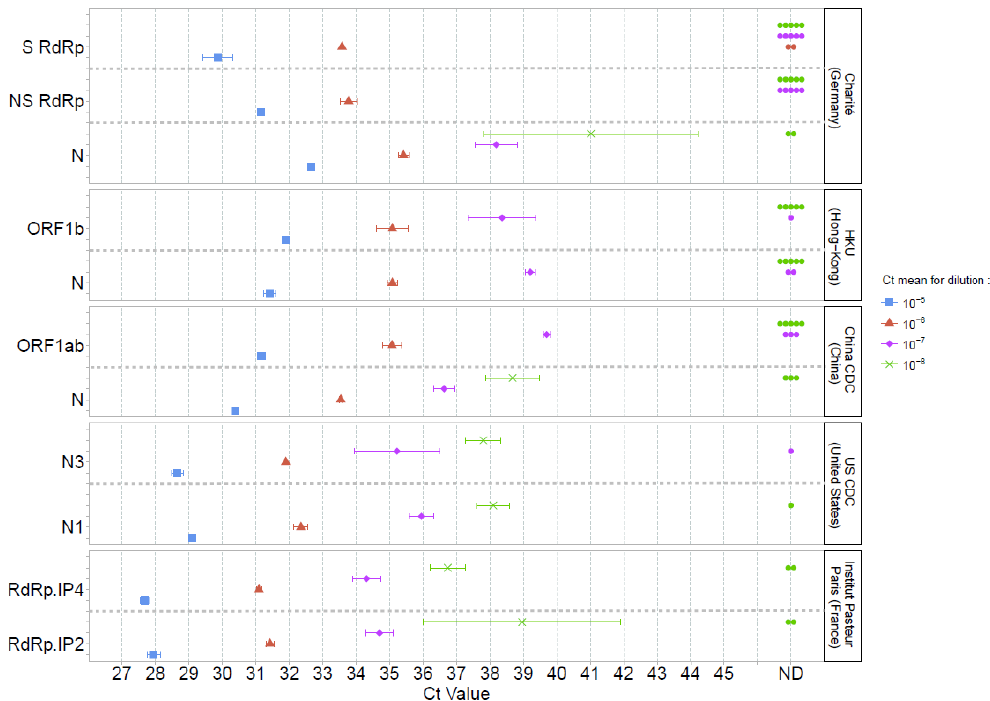
Figure 1. Mean Ct values and standard deviations obtained using five PCR-based methods for SARS-CoV-2 detection. Serial dilutions of SARS-CoV-2 cell culture supernatants were used and are represented by a single color (10 −5 blue, 10 −6 red, 10 −7 pink, 10 −8 green). A point in the ND (non-detected) column (Ct value axis) indicates a negative result for one replicate.